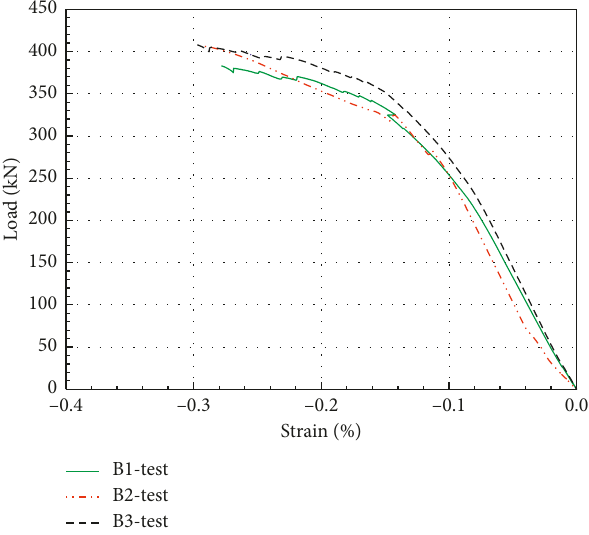
Figure 8: Curves of load-compressive strain in the concrete